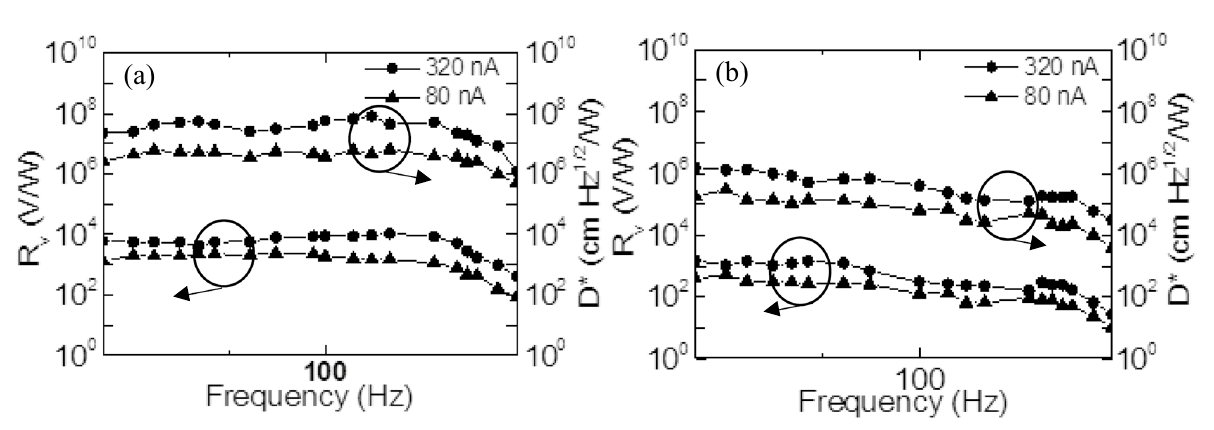
Figure 8. Measured voltage responsivity and detectivity as a function of chopper frequency at different bias currents for ( a ) bottom microbolometer (d = 1.11, p = 2.38), and ( b ) top microbolometer.